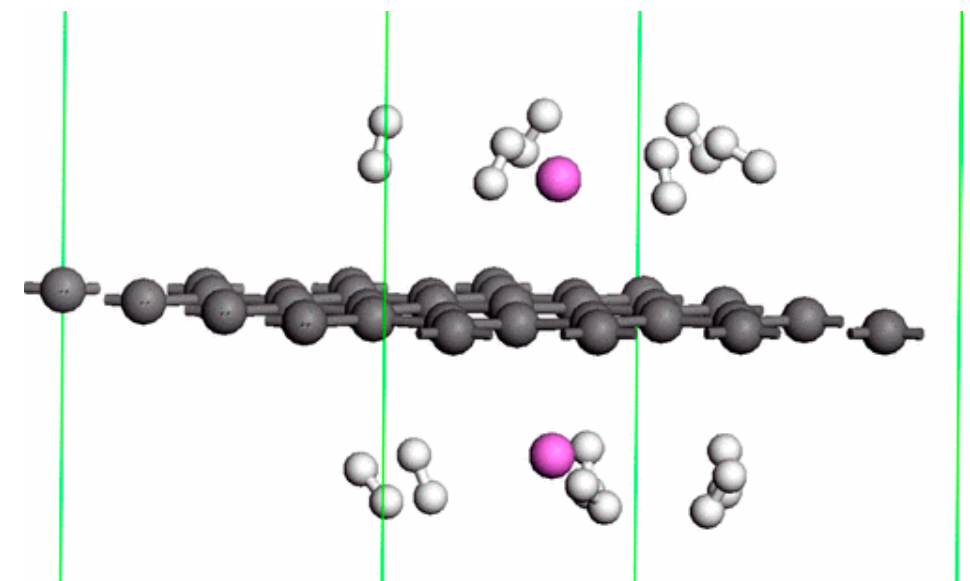
Figure 8. Results of computer simulation of double sided hydrogenated graphene decorated with Al. Hydrogen atoms were marked with white color, while aluminum with magenta. Reproduced with permission from Ao et al., PHYSICAL REVIEW B; published by American Physical Society, 2010.